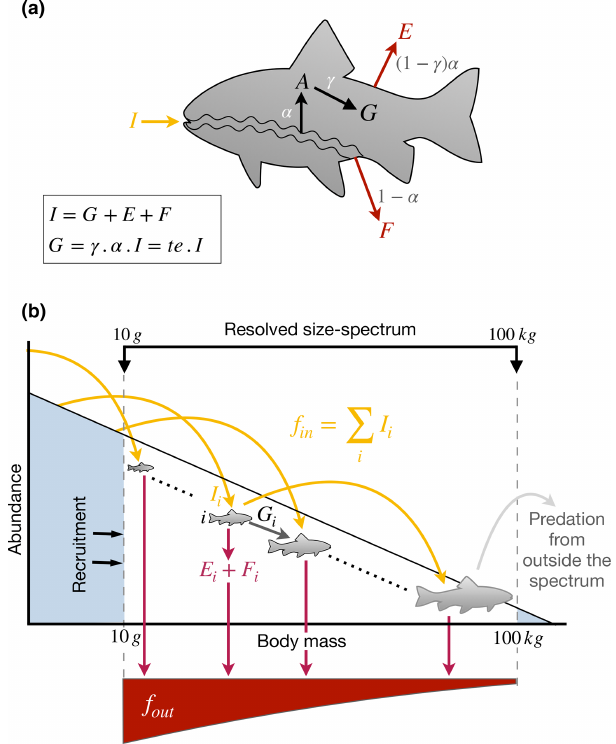
Figure 3. Schematic of the flow of elements (a) within an individ- ual and (b) through the size spectrum. I : ingestion; G : growth and reproduction; A : absorption; E : excretion; F : egestion (feces); α : absorption efficiency, i.e., assimilation efficiency net of egestion; γ : somatic assimilation efficiency, i.e assimilation allocated to growth; f in : flux entering the spectrum; f out : flux going out of the